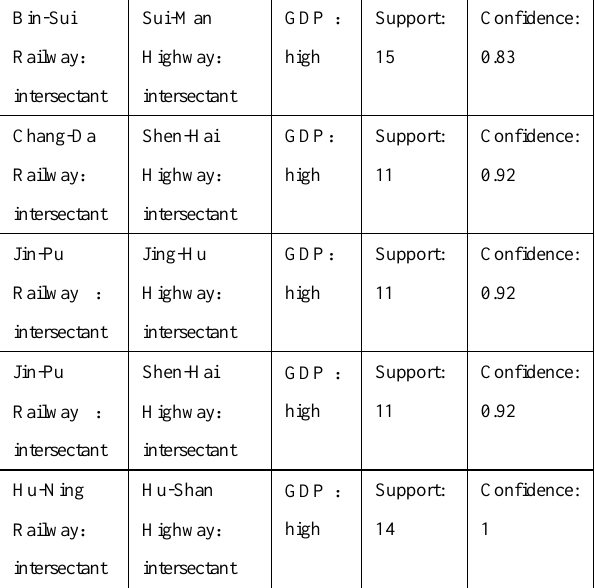
Table 2. Filtered result of frequent